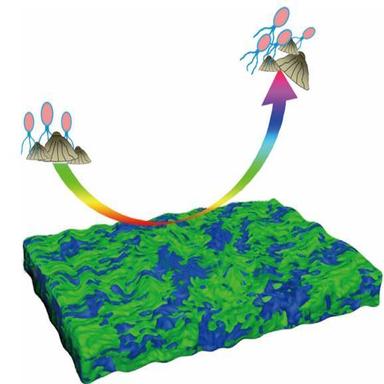
Schematic representation of an amphiphilic polymer coating and phase separation surface (a green hydrophilic polyethylene glycol segment and a blue lipophilic fluoropolymer segment).